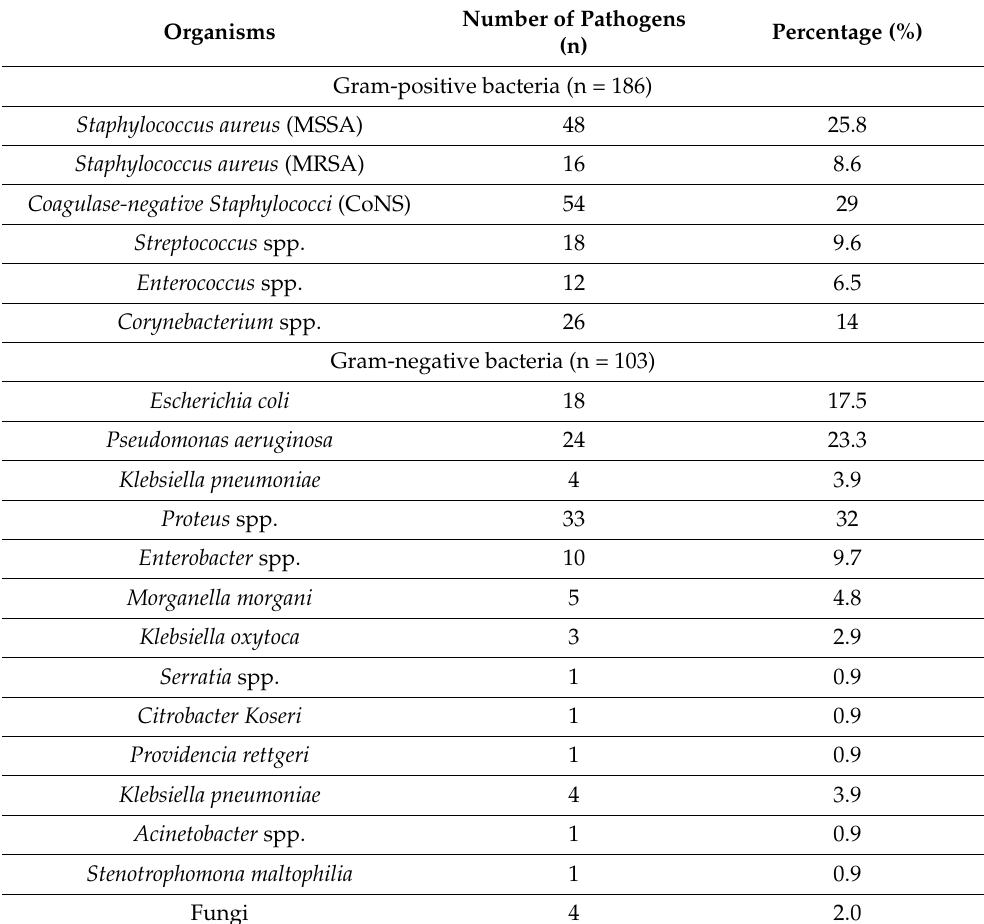
Table 2. Frequency of microorganisms isolated from the DFUs.